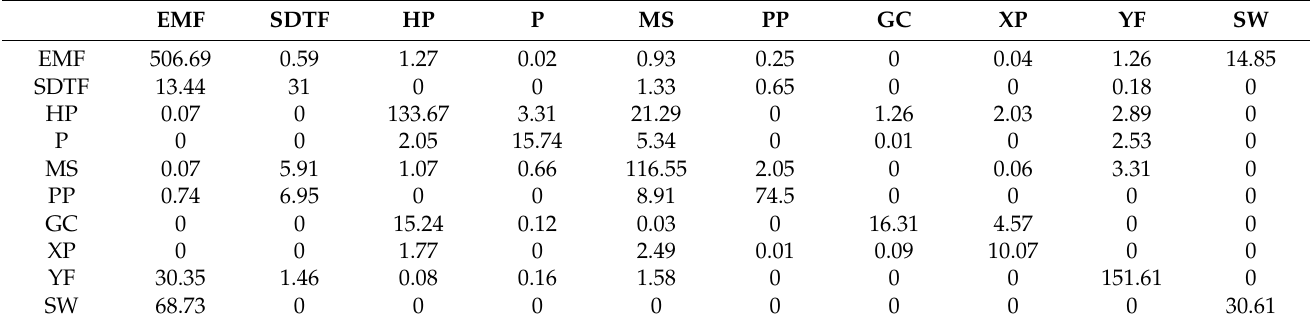
Table A2. Migration matrix and biomes extension gains in km 2 . The results are the median of the three regional climate models projections.